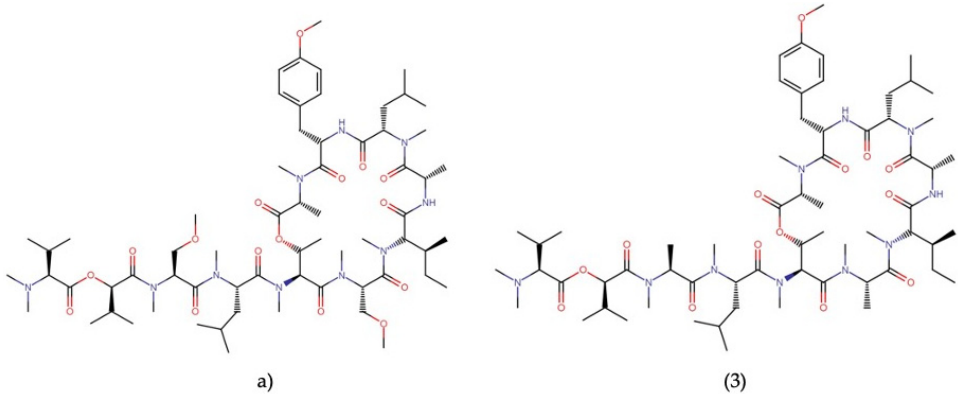
Figure 10. Chemical structures of ( a ) coibamide A and its derivative ( 3 ). This molecule showed potent cytotoxicity against NCI-H460 lung cancer cells and Neuro-2a mouse neuroblastoma cells, with LC 50 values lower than 23 nM, showing arrest in the G1 phase of the cell cycle [17]. In addition, coibamide A was evaluated against sev- eral tumor cell lines, including the NCI-60 panel of cancer cell lines , showing promising cy- tostatic and cytotoxic effects, with GI 50 values ranging between 0.4 and 7.6 nM, being the MDA-MB-468 line being the most sensitive (Table 6) [17,49,63]. Table 6. Coibamide A activity on cancer cell lines. Tested Cell Lines